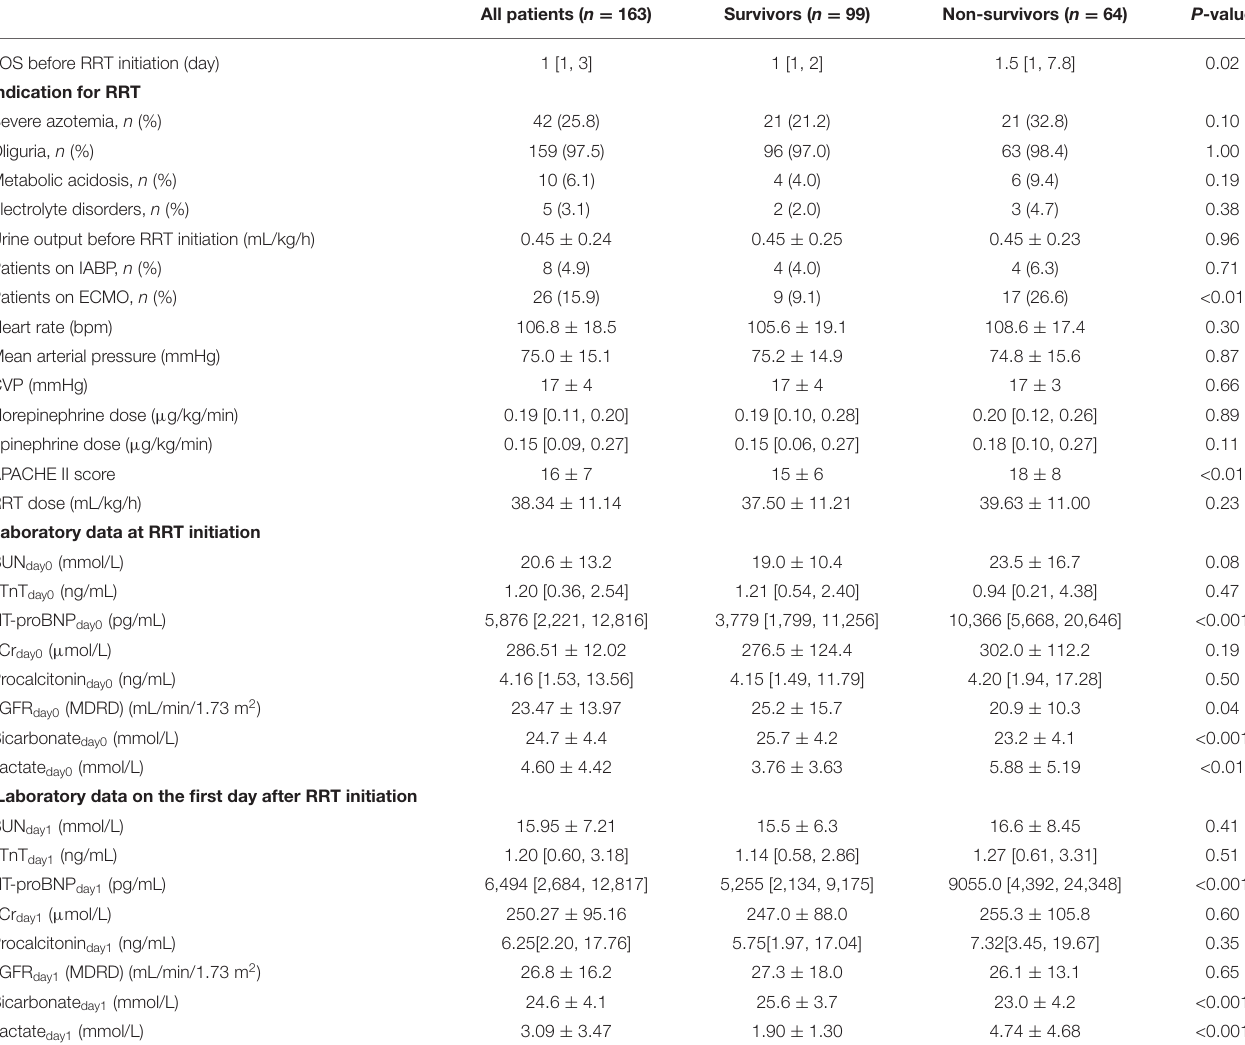
TABLE 2 | Patient characteristics at RRT initiation grouped by 28-day mortality.